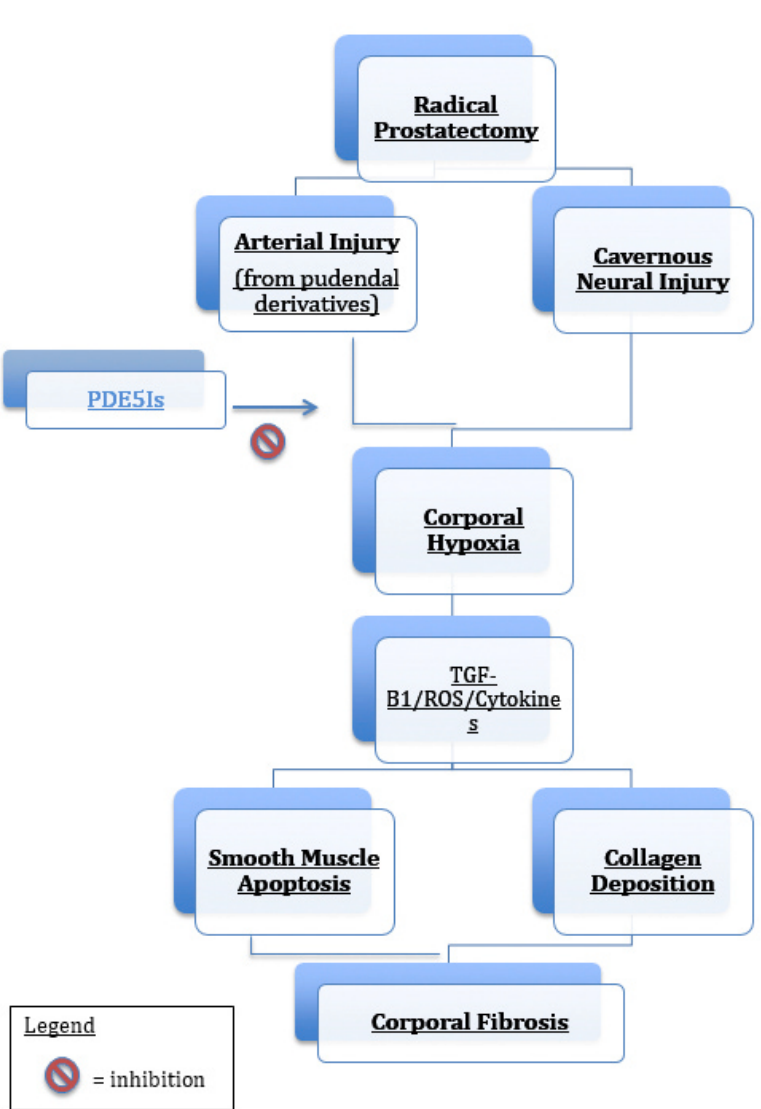
Figure 1. Pathophysiology of erectile dysfunction after radical prostatectomy. ROS, reactive oxygen species; TGF- β 1, transforming growth factor beta